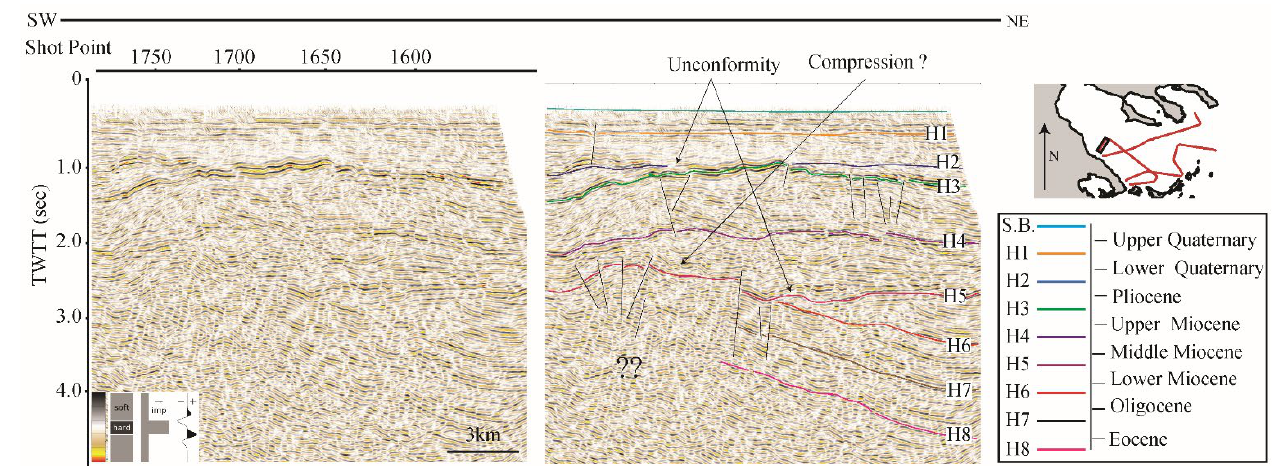
Figure 5. Seismic Line ΝΟ . Left part: un-interpreted regional seismic profile. Right part: interpreted seismic section with highlighted key horizons and the most prominent tectonic elements.